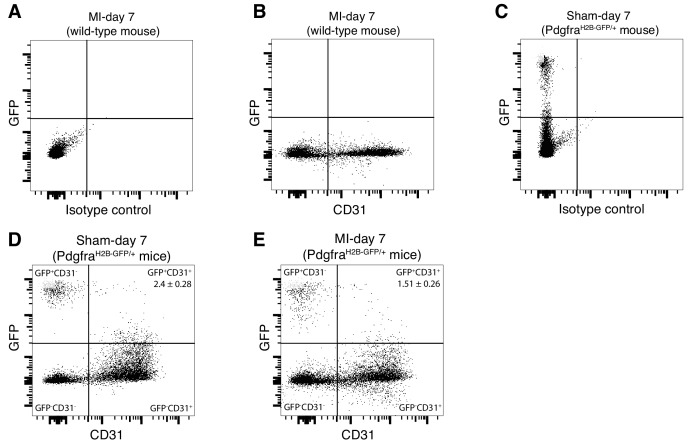
FACS data supporting F-EC population.FACS plots showing expression of GFP or CD31 (axis label) in the (A) wild type sample stained with isotype control antibody; (B) wild type sample stained with anti-CD31 antibody; (C) PdfgraGFP/+ sample stained with isotype control antibody; (D, E) PdfgraGFP/+ sample stained with anti-CD31 antibody 7 days after Sham (D) or MI (E) surgery. Numbers indicate percentage of GFP+CD31+ double positive cells in live single cells in respective plot (mean numbers indicated).